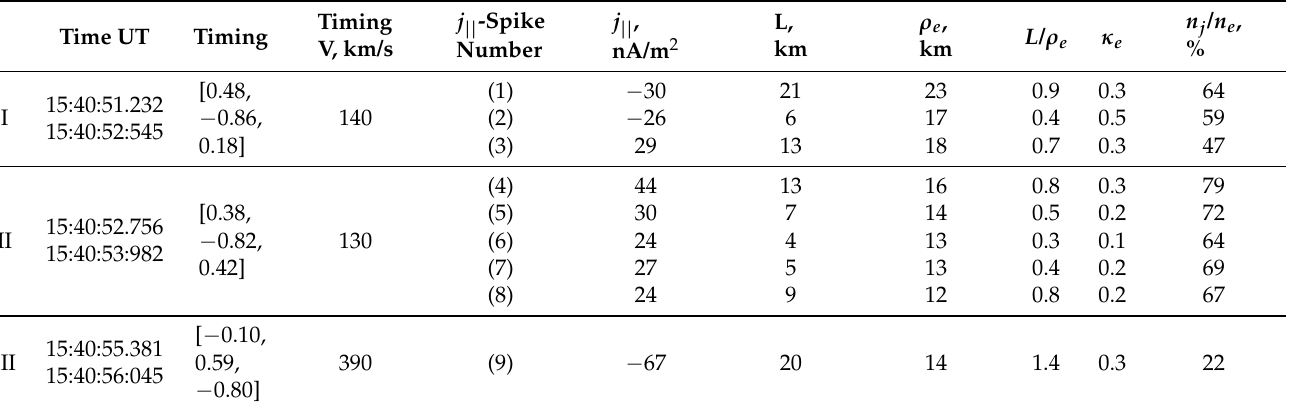
Table 1. Parameters of the observed j ||